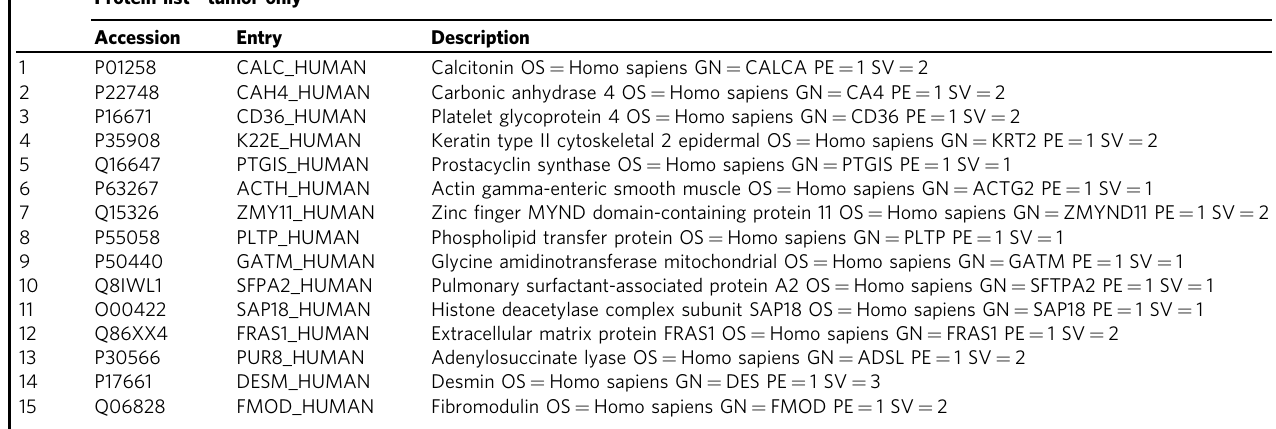
Table 2 Enlists the proteins identi fi ed only in tumor patient sample through mass spectrometric studies. Protein list — tumor only